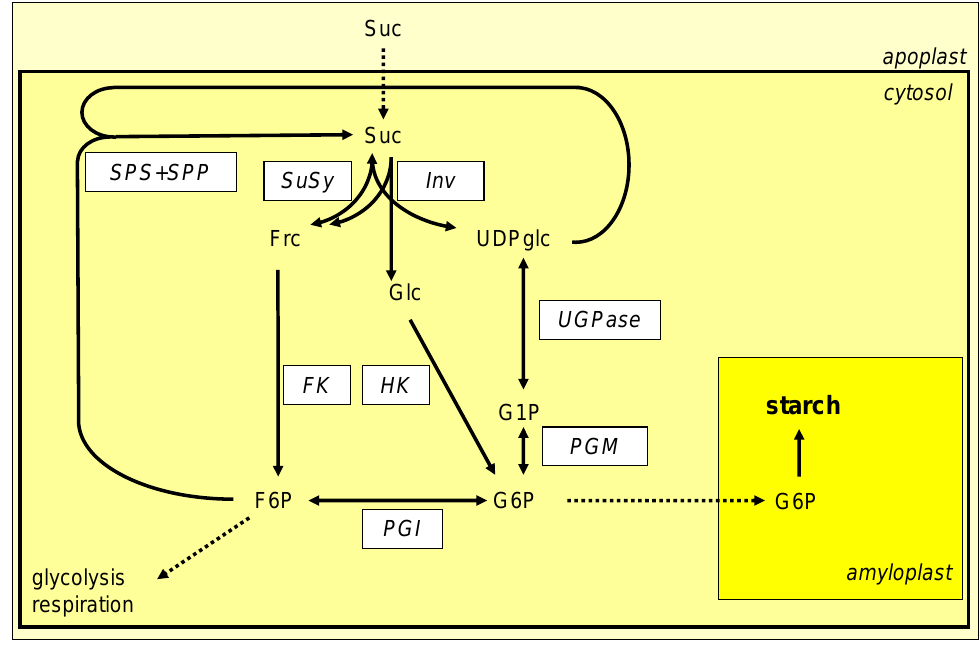
Figure 5: The pathway by which sucrose is transformed to starch in the potato tuber. The reac- tions take place in different cellular compartments. Abbreviations: FK, fructokinase; HK, hexok- inase; Inv, invertase; PGI, phosphoglucose isomerase; PGM, phosphoglucomutase; SPS, sucrose phosphate synthase; SPP, sucrose phosphate phosphatase; SuSy, sucrose synthase; UGPase, UDP glucose pyrophosphorylase; others, see Fig.